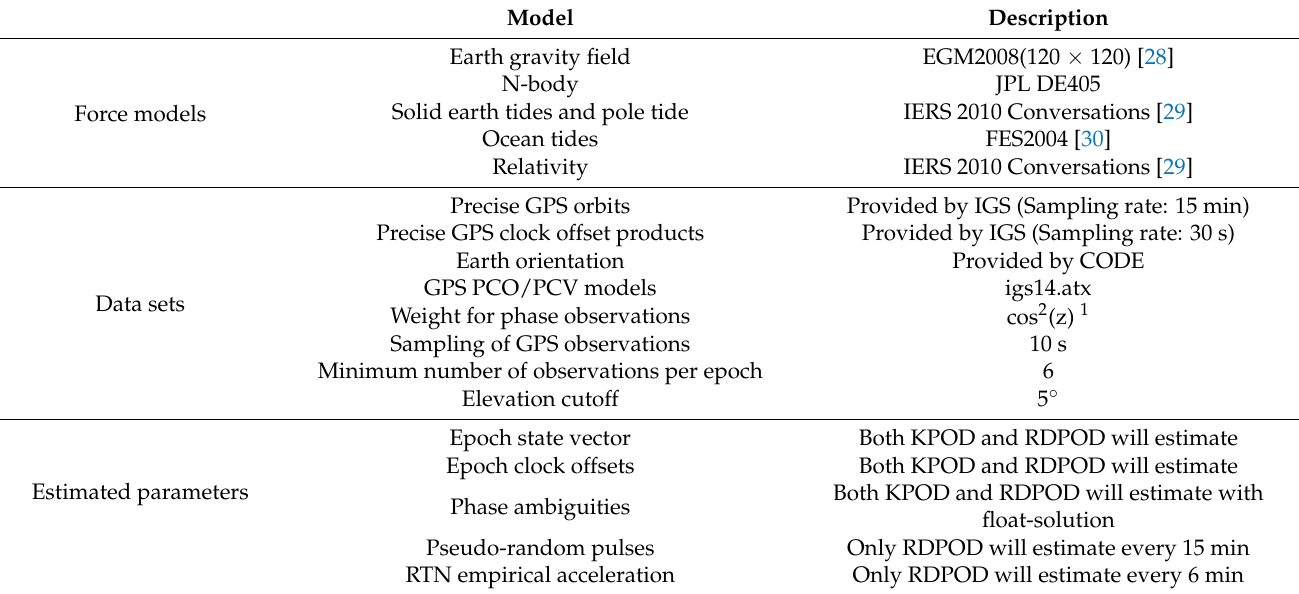
Table 1. Models, data sets and processing strategies for KPOD and